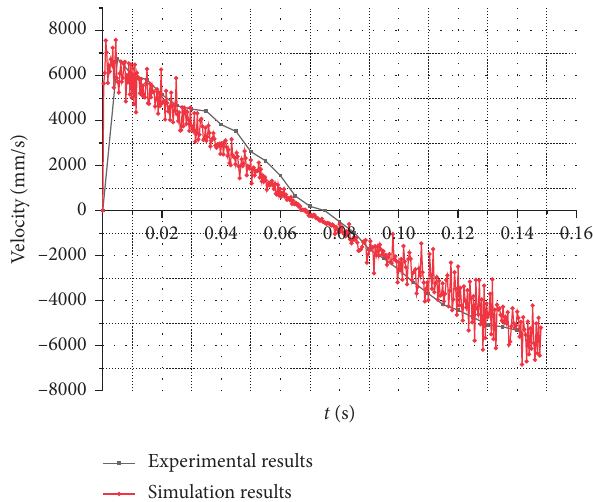
Figure 17: Comparison of the velocity-time history curves of the 1st coil.